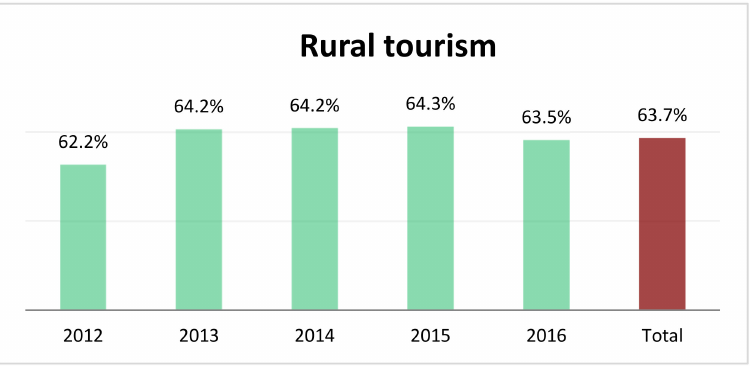
Figure 5. Efficiency results in rural tourism firms by year.